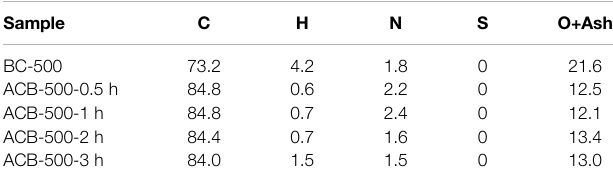
TABLE 4 | Elemental analysis results for the original bio-char and its four activated derivatives produced with different activation holding time of 0.5, 1, 2, 3 h.